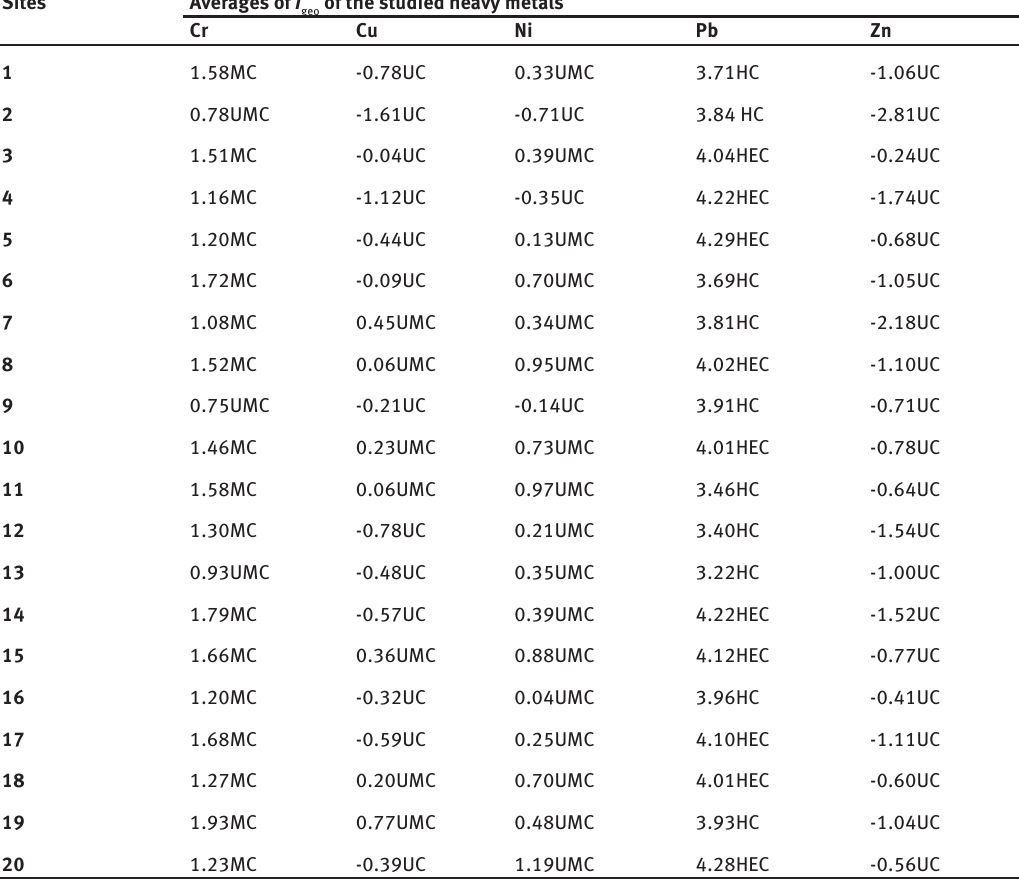
Table 5: Averages of geo-accumulation ( I Sites Averages of I